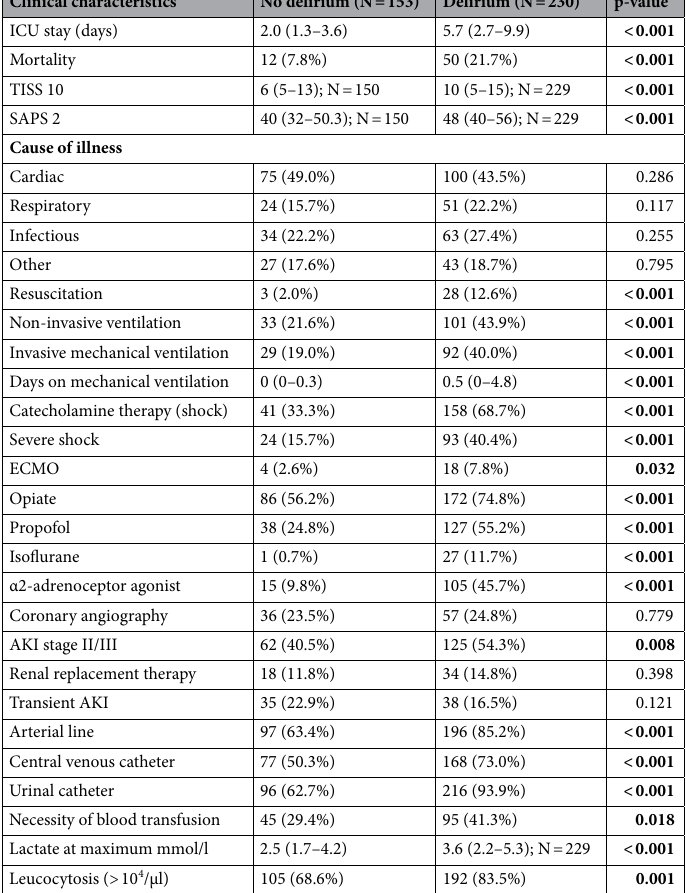
Table 3. Clinical characteristics of all patients with acute kidney injury. p value reported in bold if difference is significant (p < 0.05). Data are given as median and interquartile range (25th–75th) or number of patients (percent of all patients in